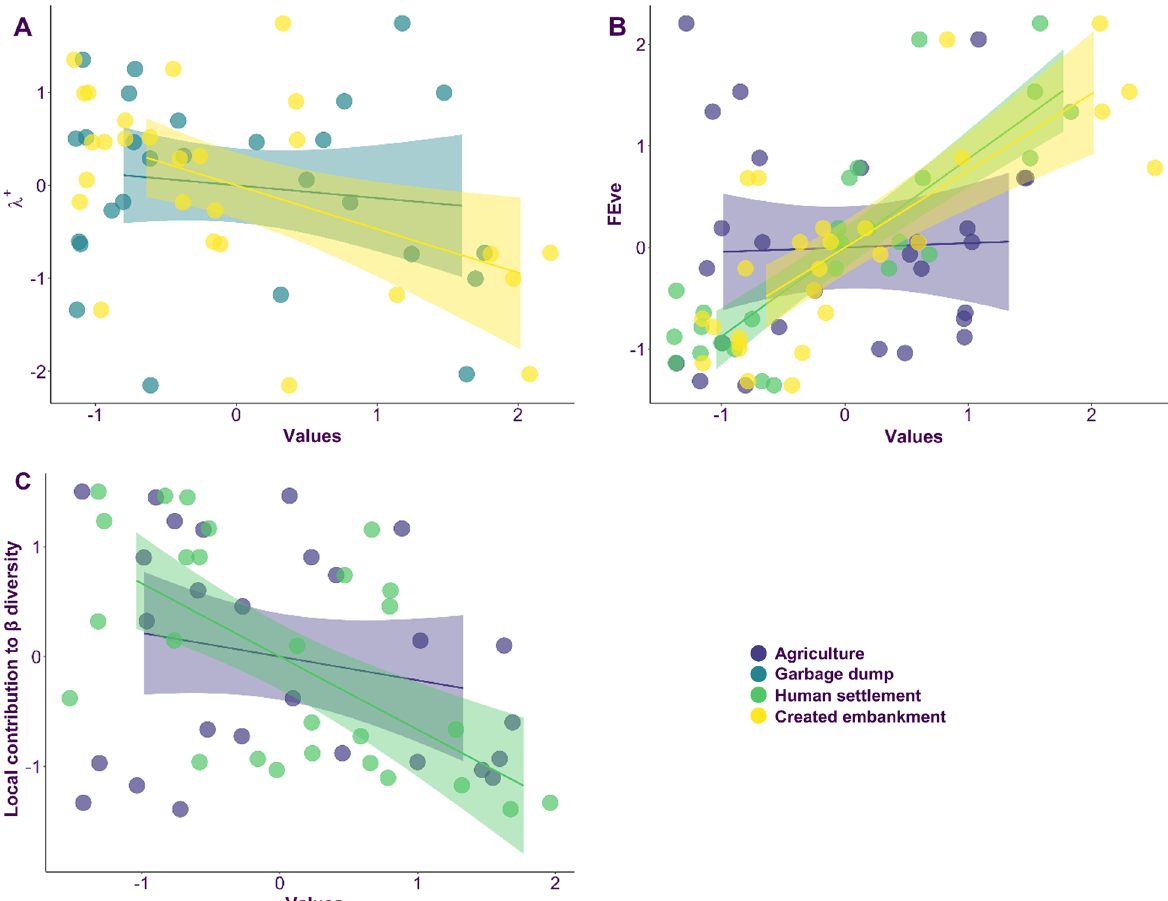
Fig. 10 Scatter plots of the multiple linear regression (best predictor combination) between A index of variation in taxonomic distinctness (λ + ) of spider community, B functional evenness (FEve) of spider community, and C local contribution to β diversity of spider community with habitat disturbance in the 27 sites studied along the Ganga River,